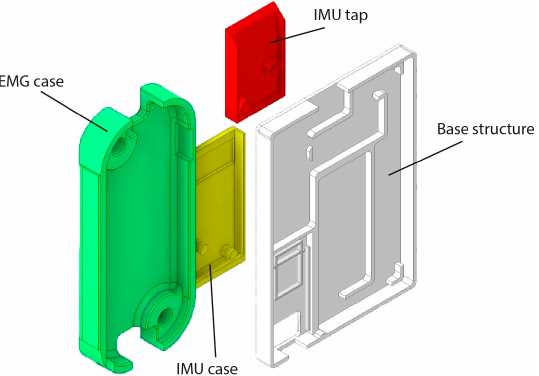
Figure 2. CAD models of the structural elements, including base structure and sensor holders.